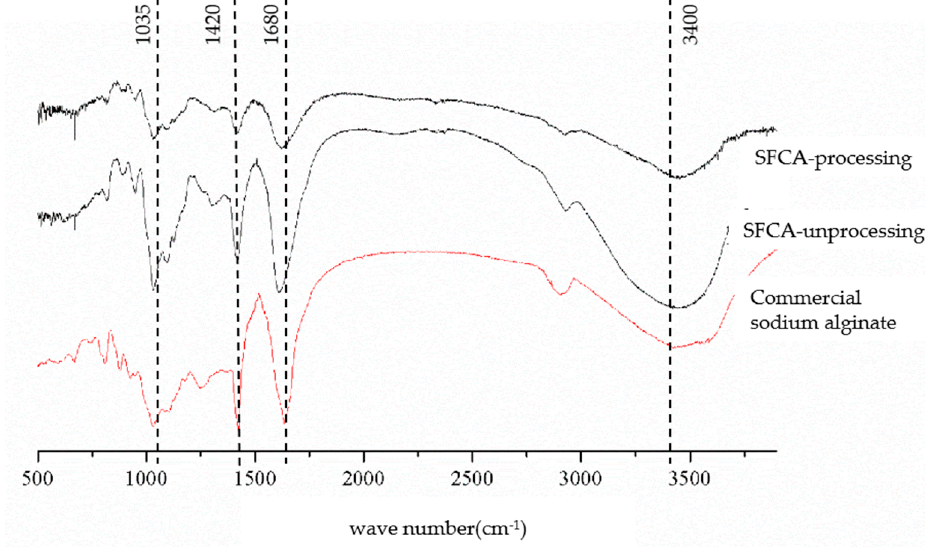
Figure 1. FT-IR spectroscopic analysis of structural features of SFCA. SFCA-processing: calcium alginate gels isolated from citric acid washed S. fusiforme ; SFCA-unprocessing: calcium alginate gels isolated from original S. fusiforme . Table 1. Chemical composition of SFCA.